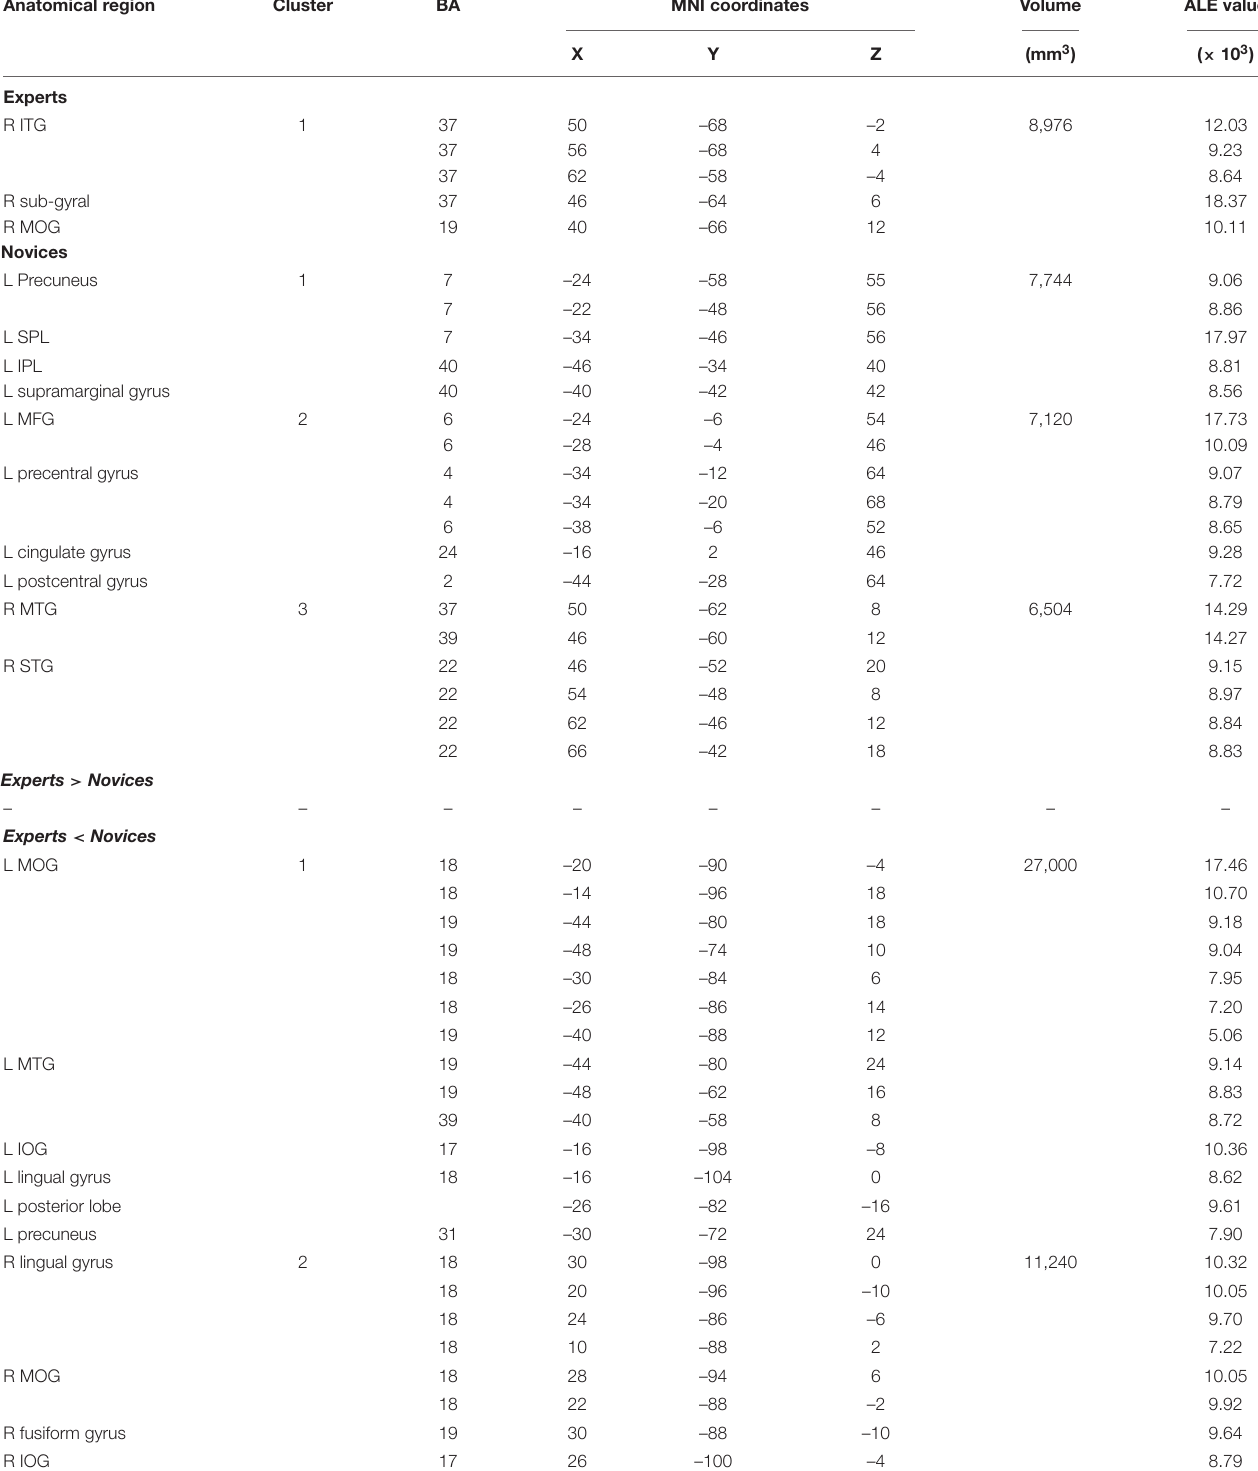
TABLE 2 | ALE meta-analysis results according to experts, novices, and contrasts. Anatomical